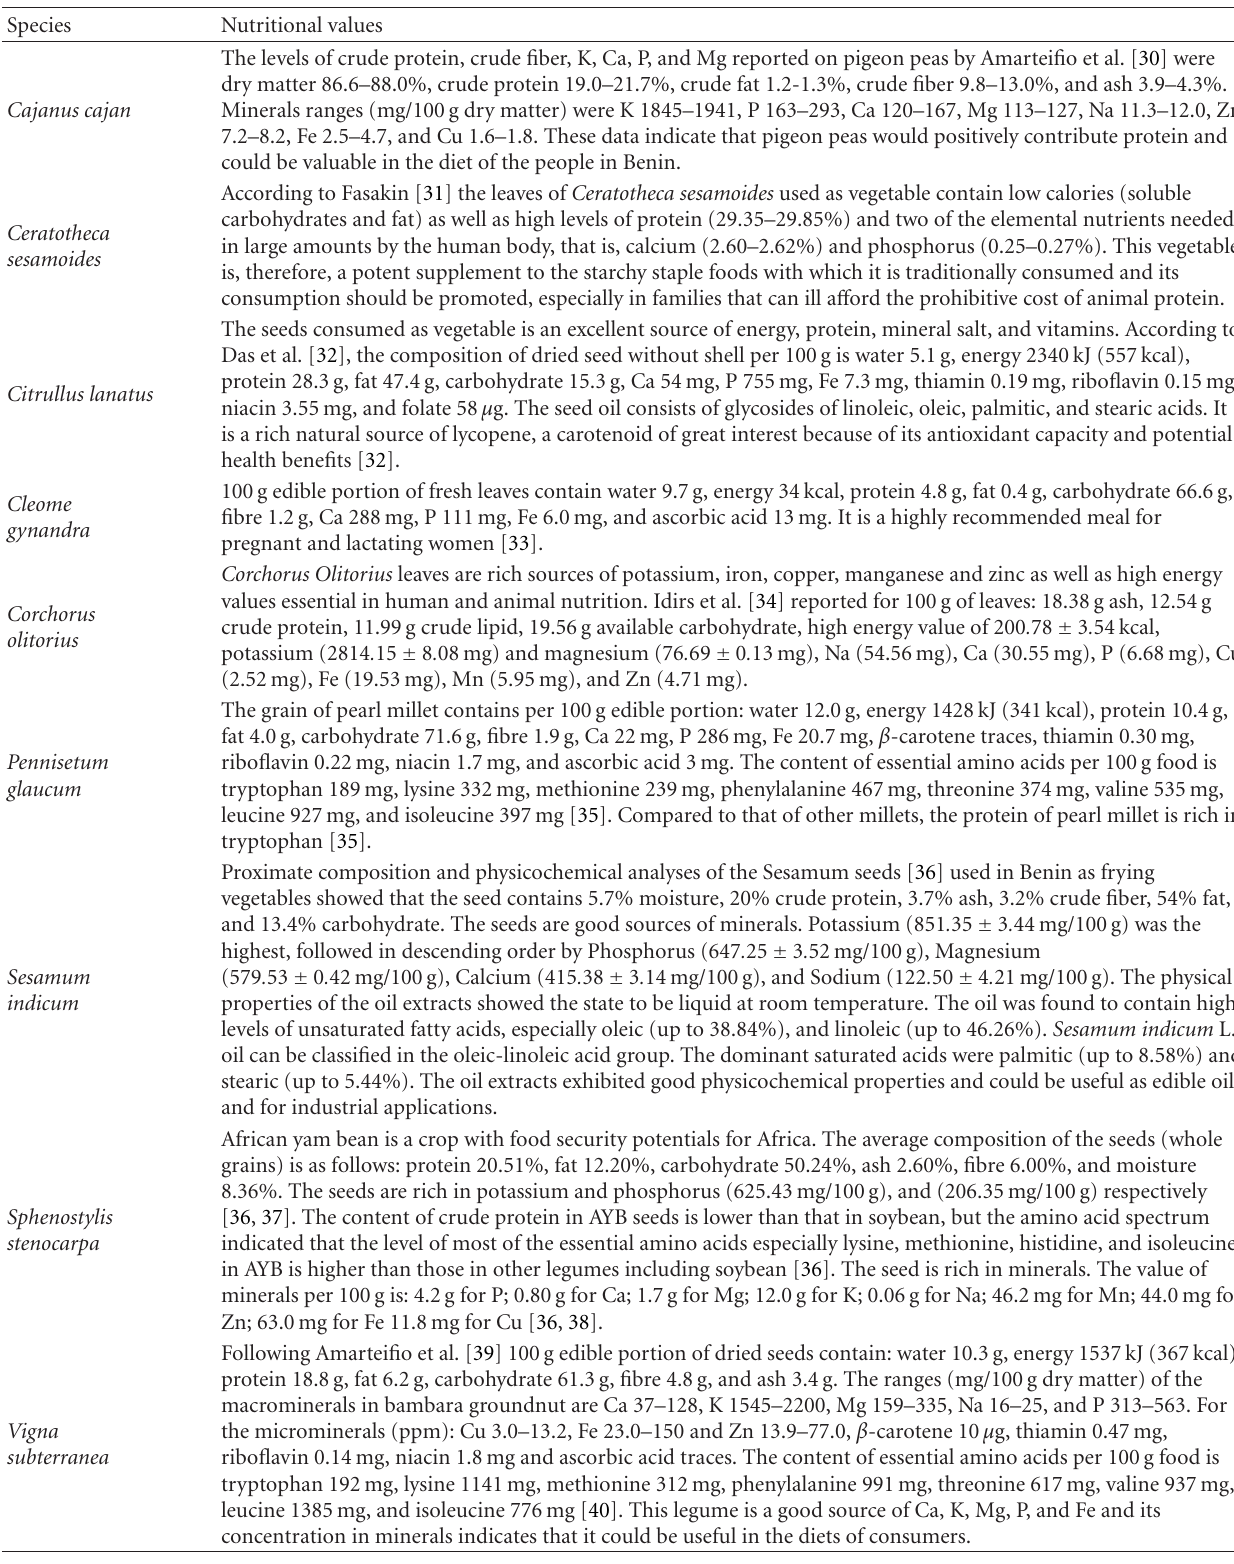
Table 5: Known nutritional values of some priority NUS in